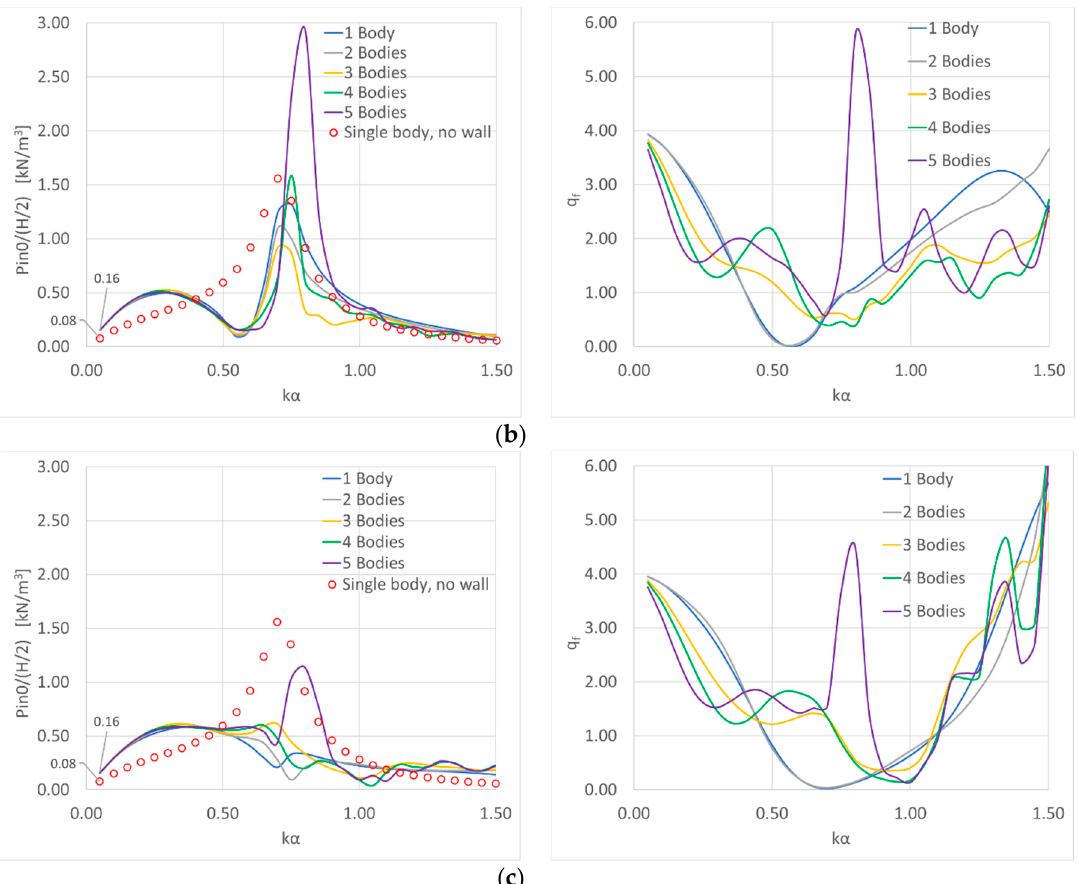
Figure 6. Air pressure inside the 1st OWC (left column figures) and array’s q f factor (right column figures) versus k α for various examined wave heading angles: ( a ) β = 0; ( b ) β = π /6; ( c ) β = π /4. Rectangular arrangement.